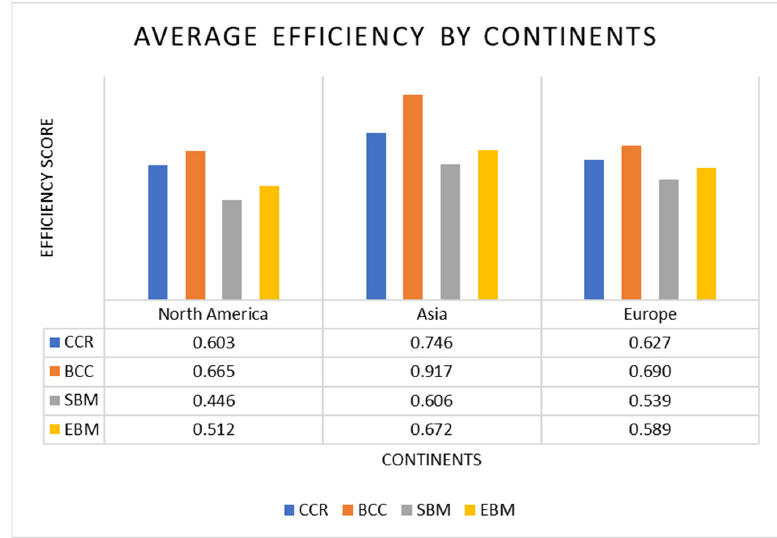
Figure 8. The average efficiency by group of continents.